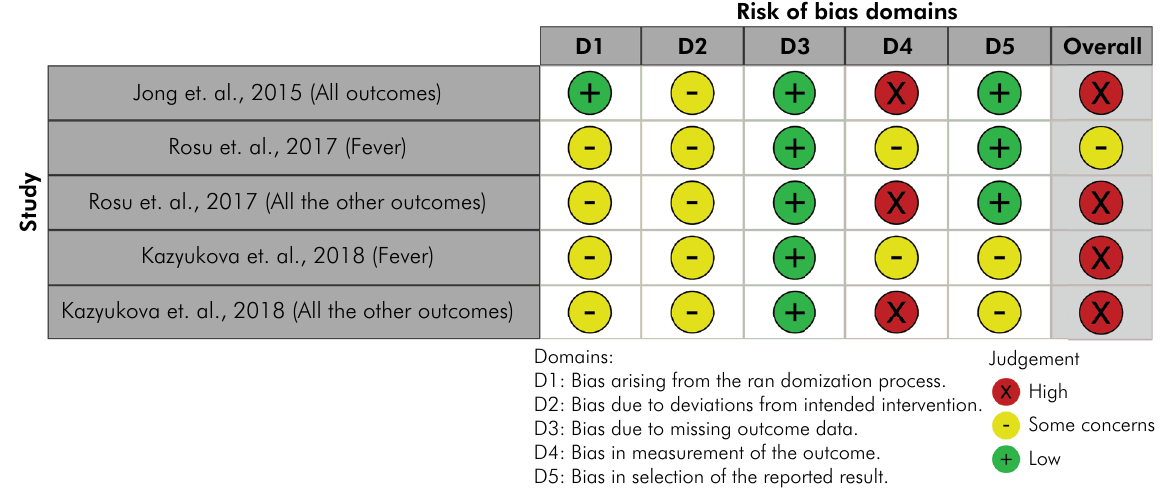
Figure 2. Quality assessment of included studies according to ROB-2 tool.